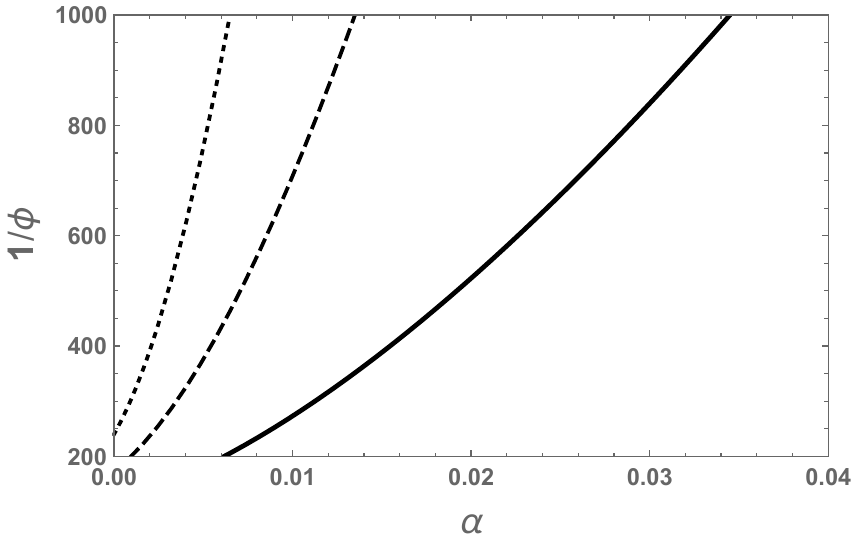
Figure 4. Dependence of the swelling ratio on degree of ionization and chain length for c s = 0, χ = 0, φ 0 = 0.008, and N = 100 (solid), 250 (dashed), and 500